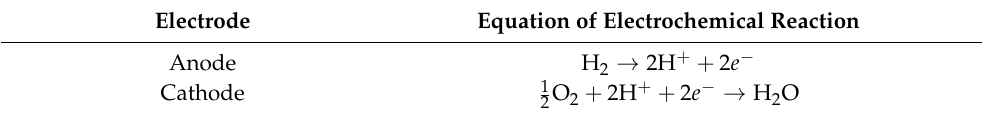
Table 1. The electrochemical reaction